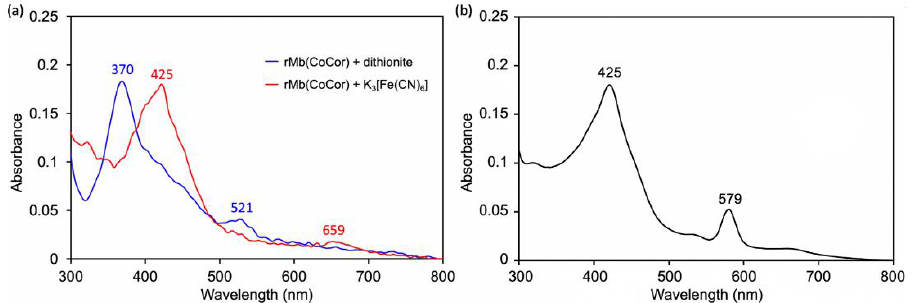
Figure 5. ESI-TOF mass spectrum of rMb(CoCor) in 10 mM ammonium acetate buffer (pH 7.0).